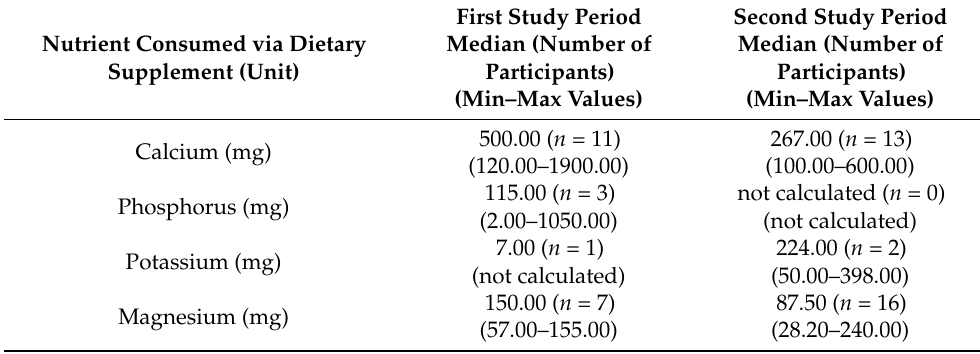
Table 5. Dietary supplement intakes among the study